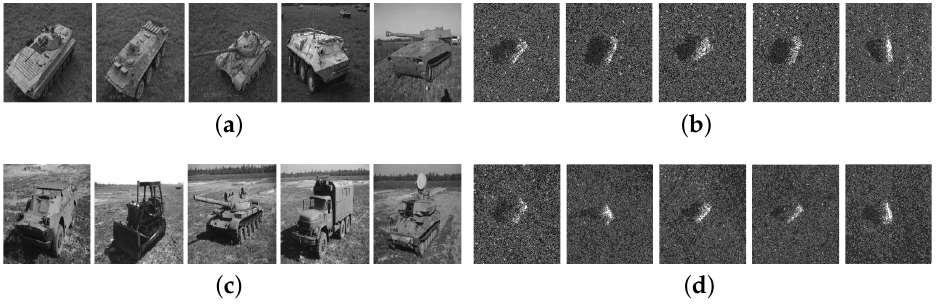
Figure 4. Optical and SAR images of targets in MSTAR dataset. Optical and SAR images for targets of ( a , b ) BMP2, BTR70, T72, BTR60, and 2S1; ( c , d ) BRDM2, D7, T62, ZIL131, and ZSU23/4.